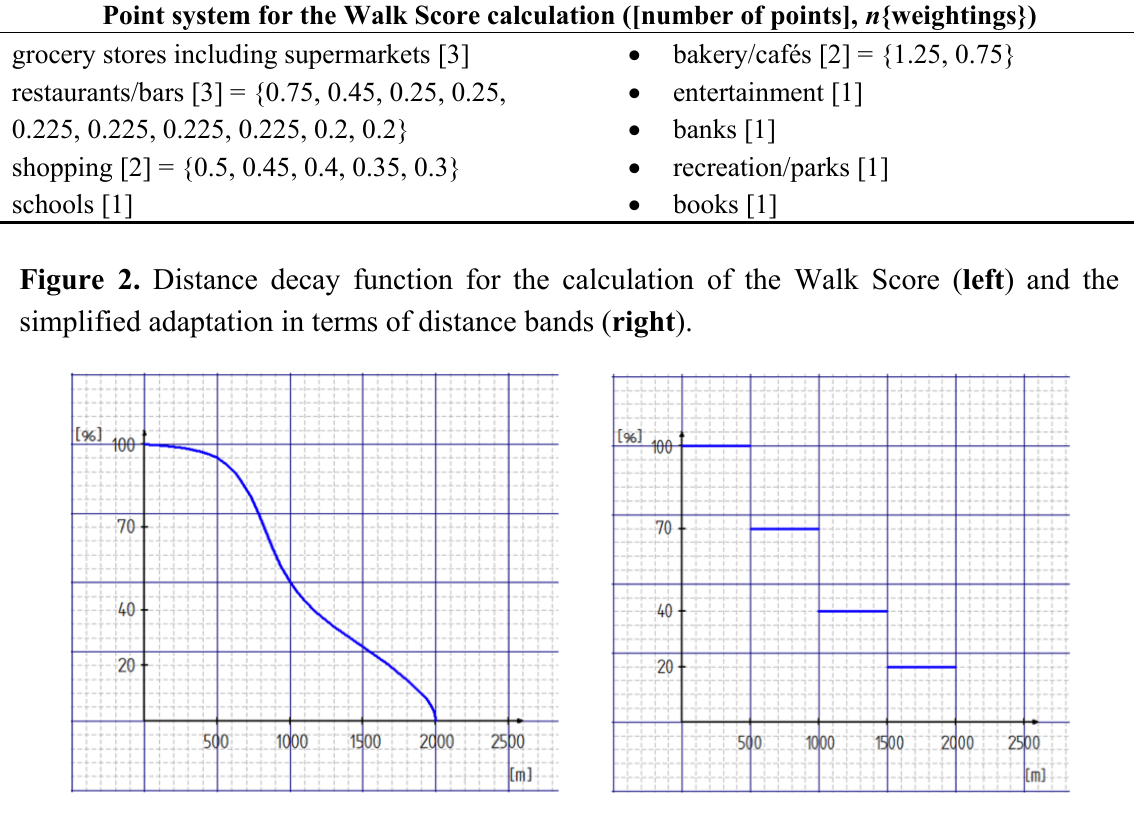
Table 1. Categories of errands used for Walk Score calculation in this study (adopted from [20]).